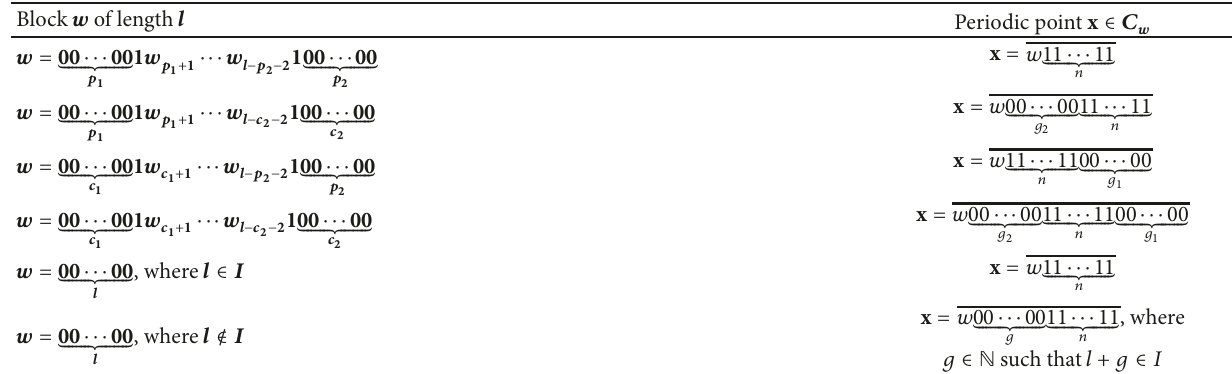
Table 2: Cases for block